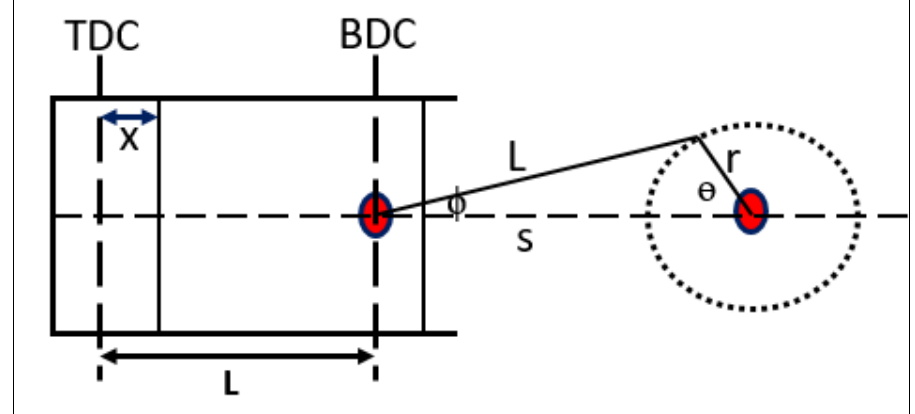
Figure 2. Geometry of the